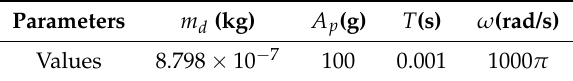
Table 1. The parameters used for the simulation.